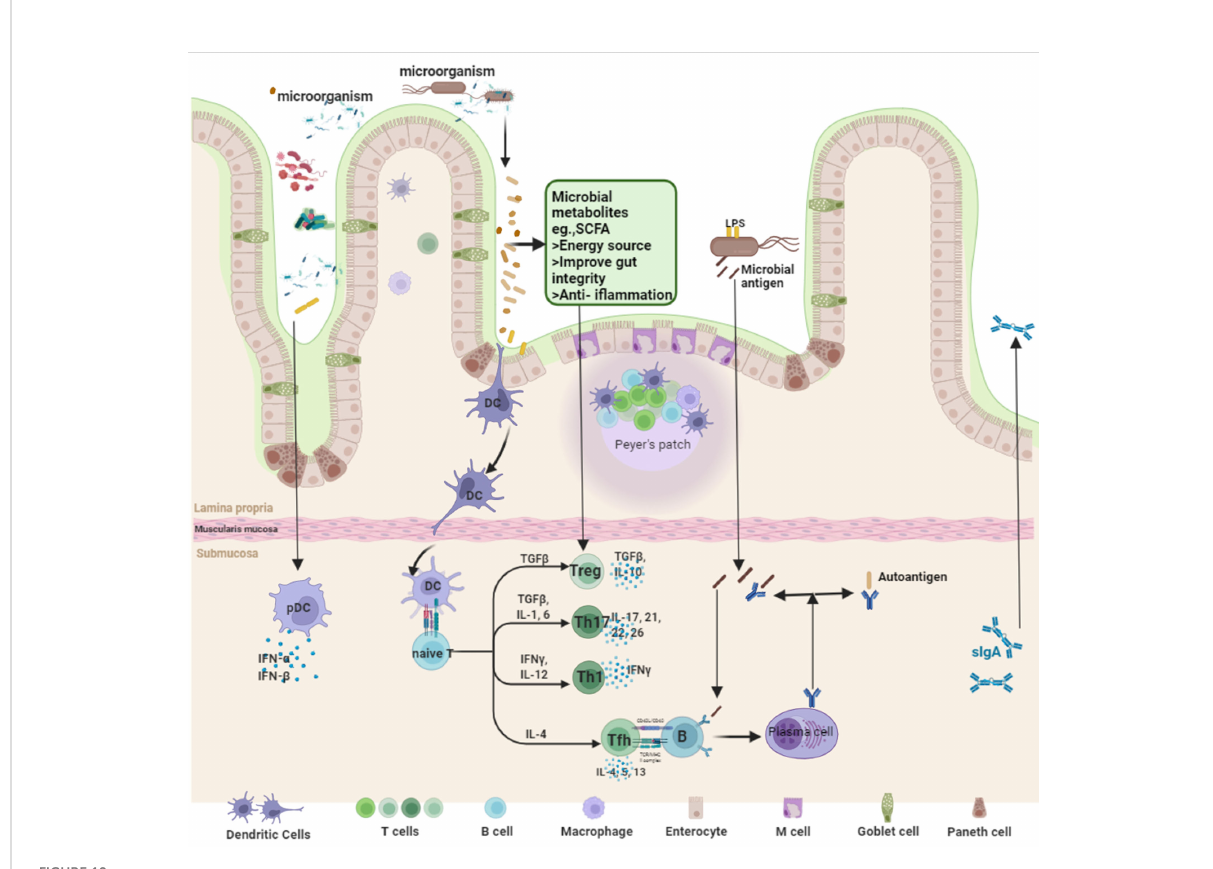
FIGURE 10 The intervention mechanism of fecal microbiota